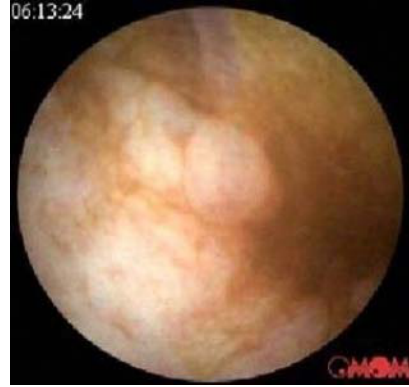
Figure 3: Crohn’s Disease Figure 4: Adenocarcinoma